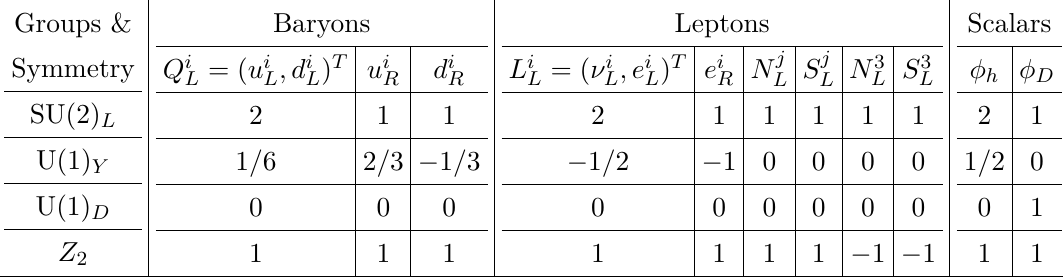
Table 1 . Particle contents and their corresponding charges under different gauge groups and discrete symmetry. The index i is for three flavours, running from 1 to 3 whereas the index j runs from 1 to